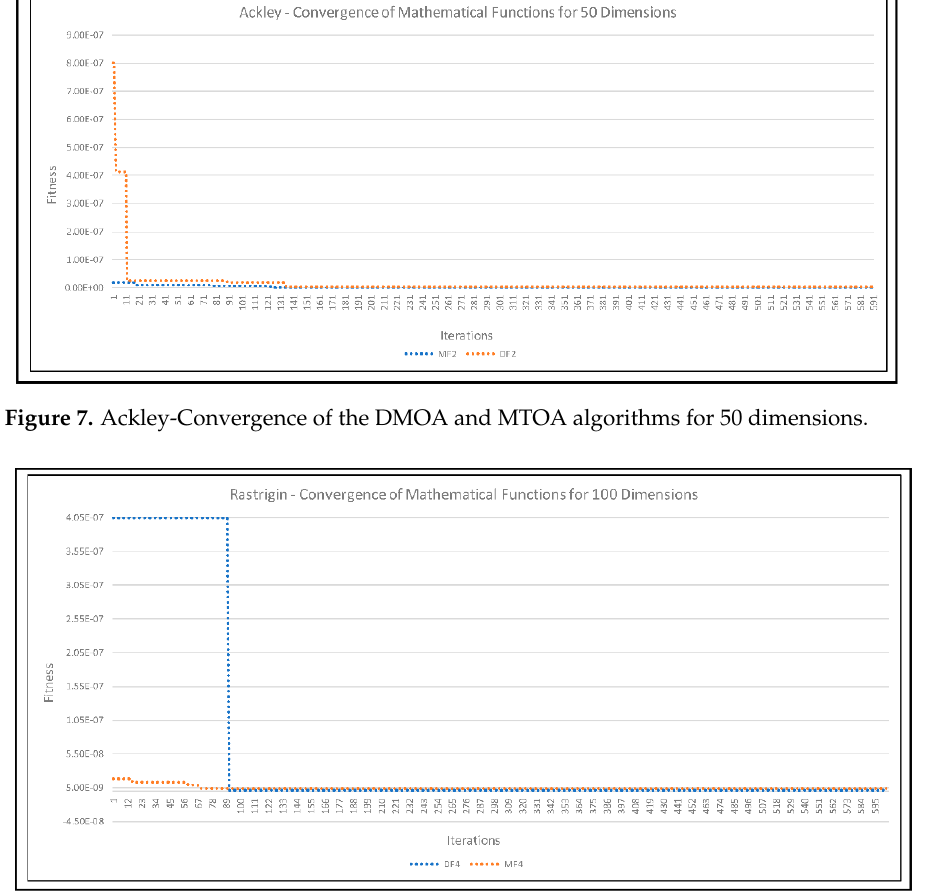
Figure 8. Rastrigin Convergence of the DMOA and MTOA algorithms for 100 dimensions.